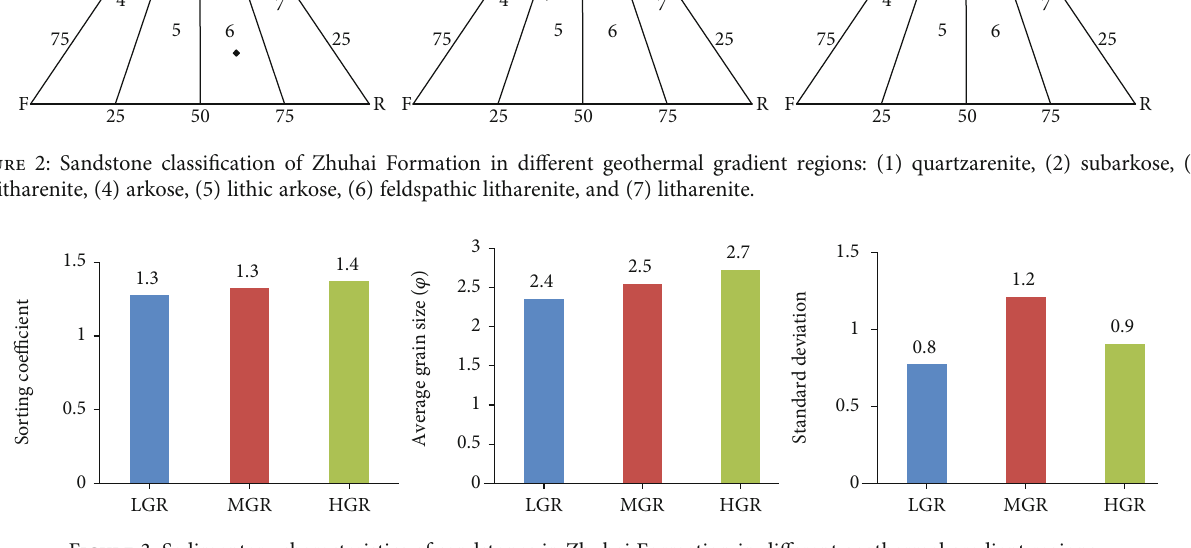
Figure 3: Sedimentary characteristics of sandstones in Zhuhai Formation in di ff erent geothermal gradient